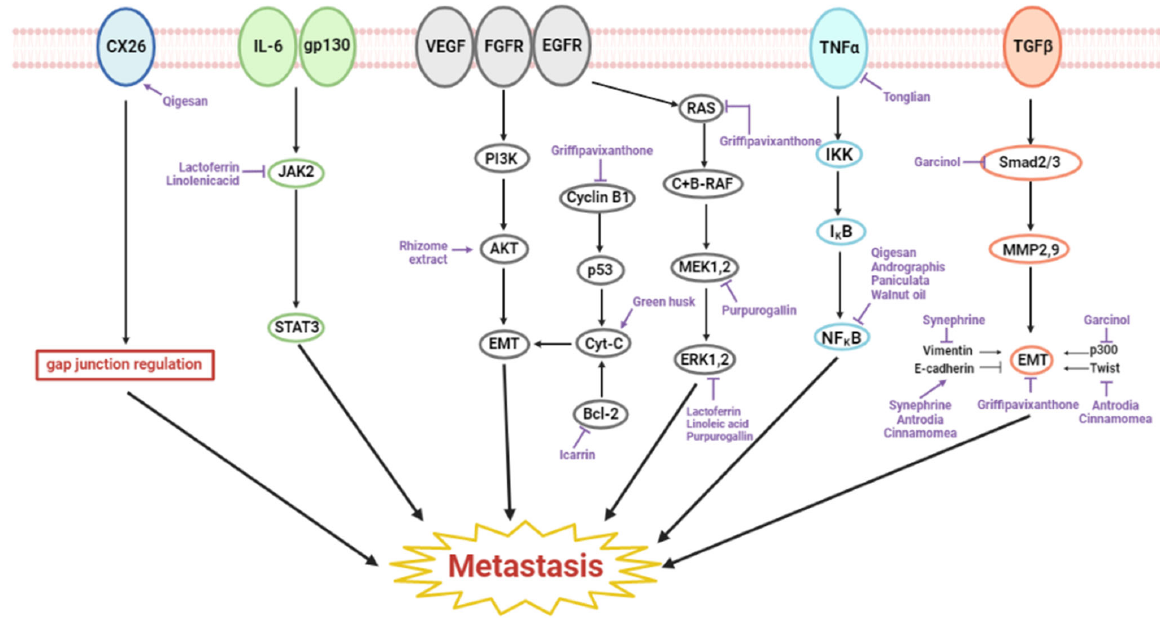
Figure 3. Schematic diagram of metastasis ‐ inhibiting natural products in esophageal